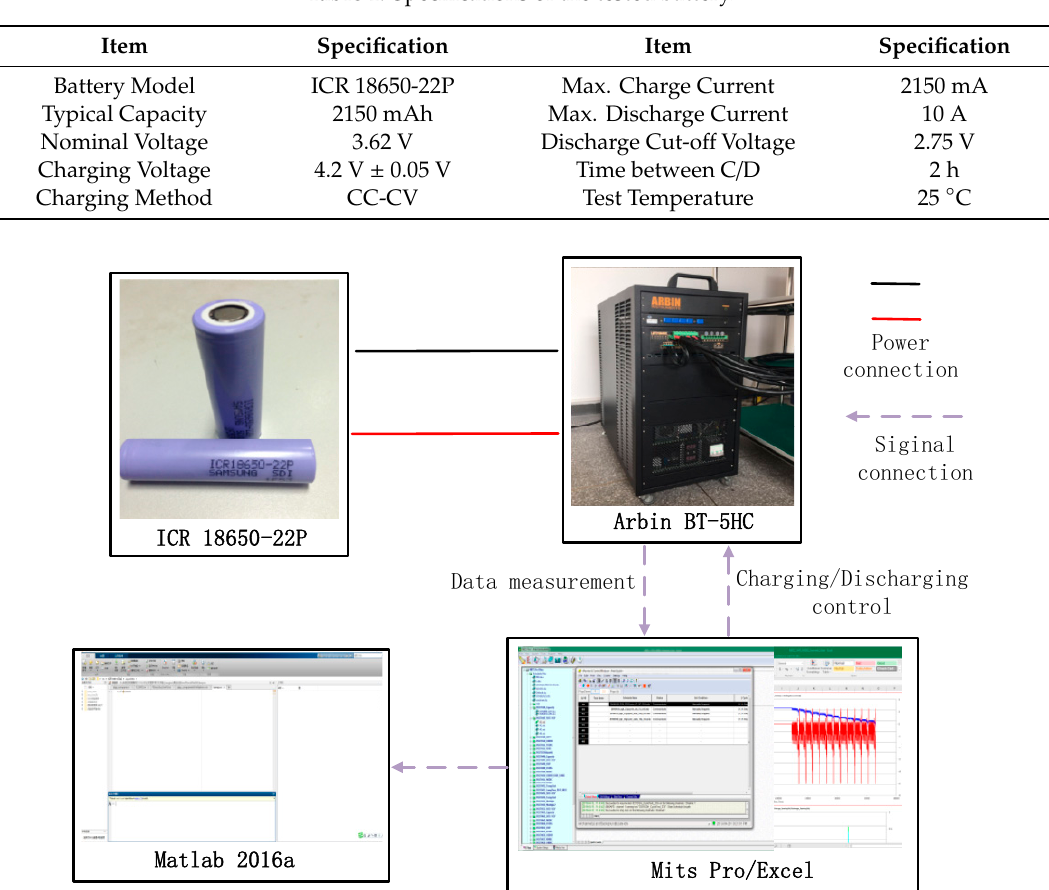
Figure 2. Schematic diagram of the test bench.